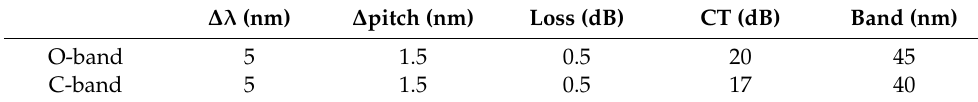
Table 2. O- and C-band wave decomposition multiplexing parameters.